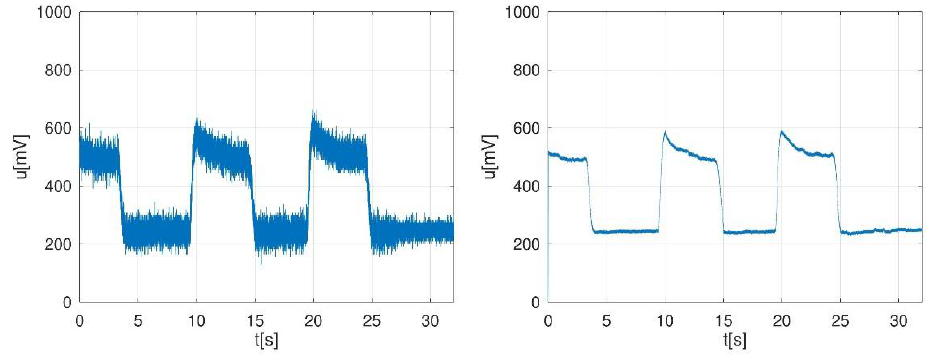
Figure 6. An example of noisy captured signals ( left ), captured signals after filtering ( right